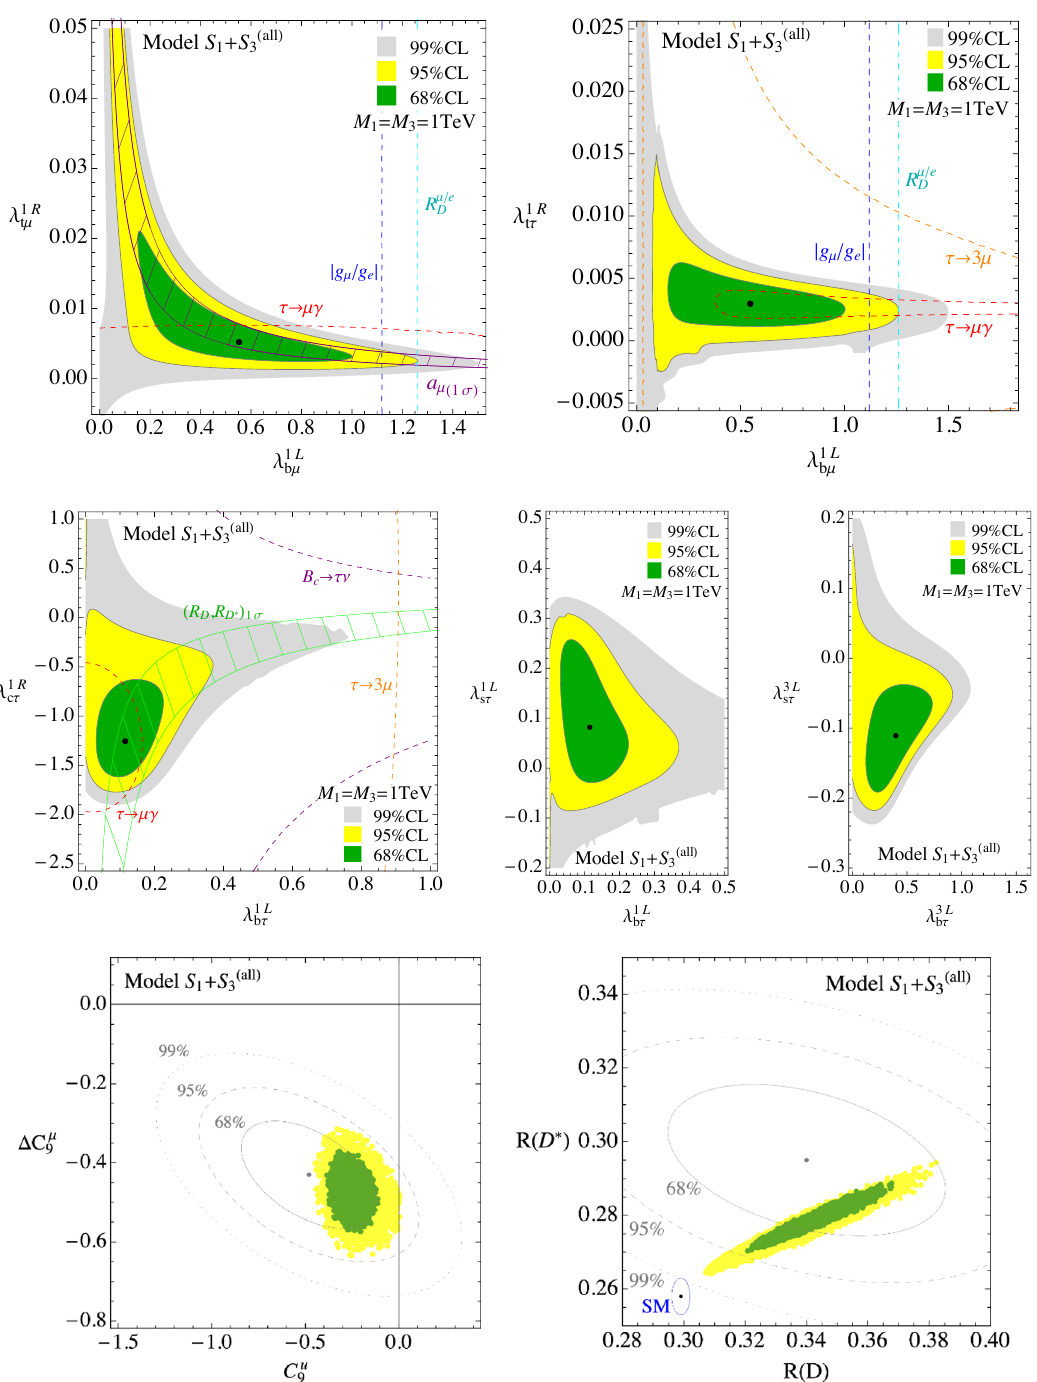
Figure 6 . Result from the fit in the S 1 + S 3 ( all ) model, aimed at addressing all anomalies (see description in the